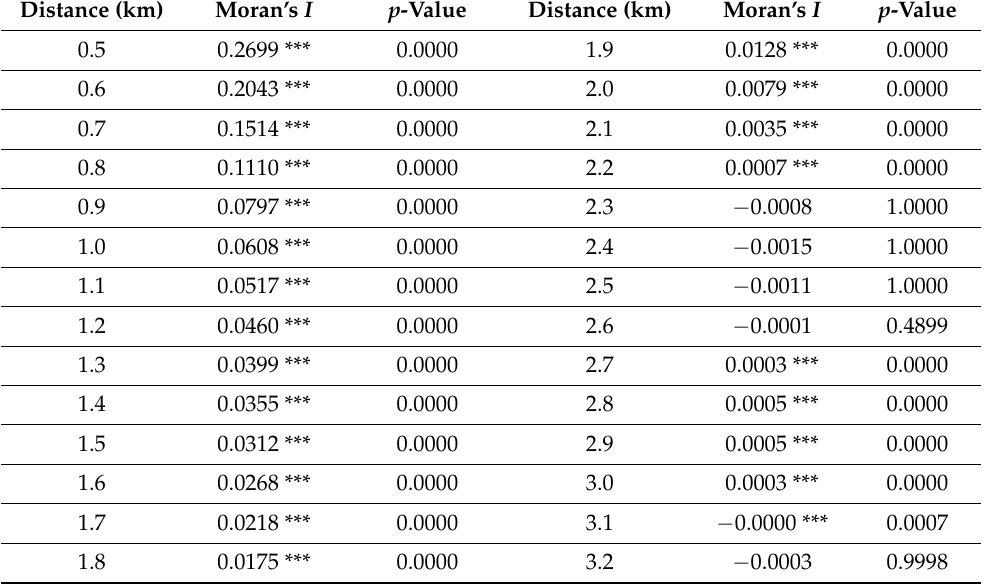
Table 4. Moran’s I statistics. Spatial autocorrelation of the predicted probability of a farm being infected with HPAI among neighboring farms with respect to the distance between pairs of farms (km).